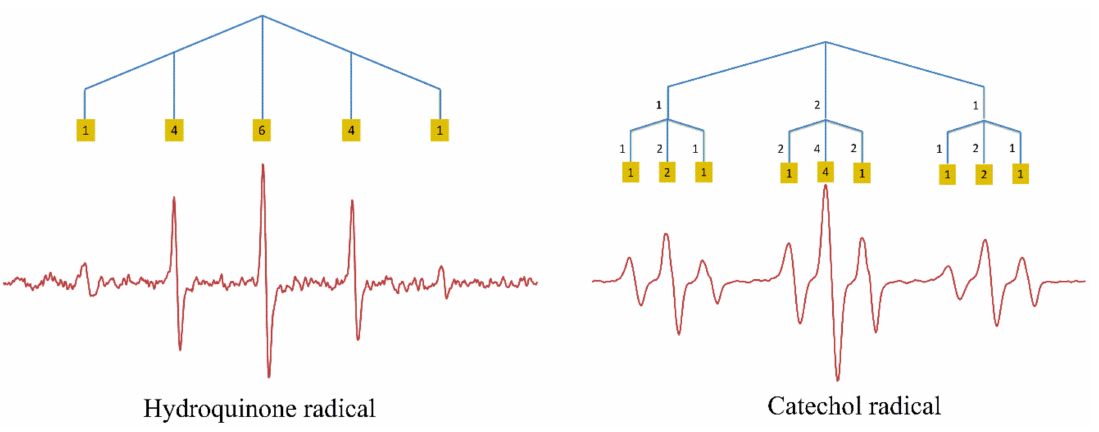
Figure 1. Experimentally obtained spin resonance spectroscopy (ESR) spectra of the hydroquinone radical and the catechol radical with the protons causing the splitting of the signal. The relative intensities of the peaks are given in yellow